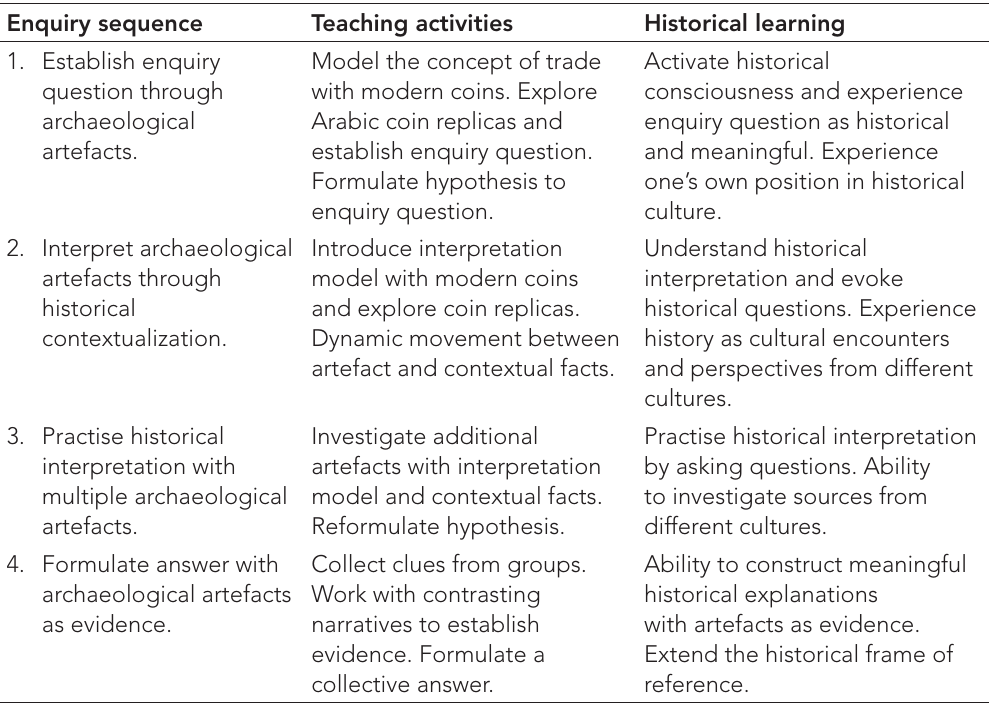
Table 1: The four-step enquiry sequence, showing the operationalization in terms of teaching activities and intended learning